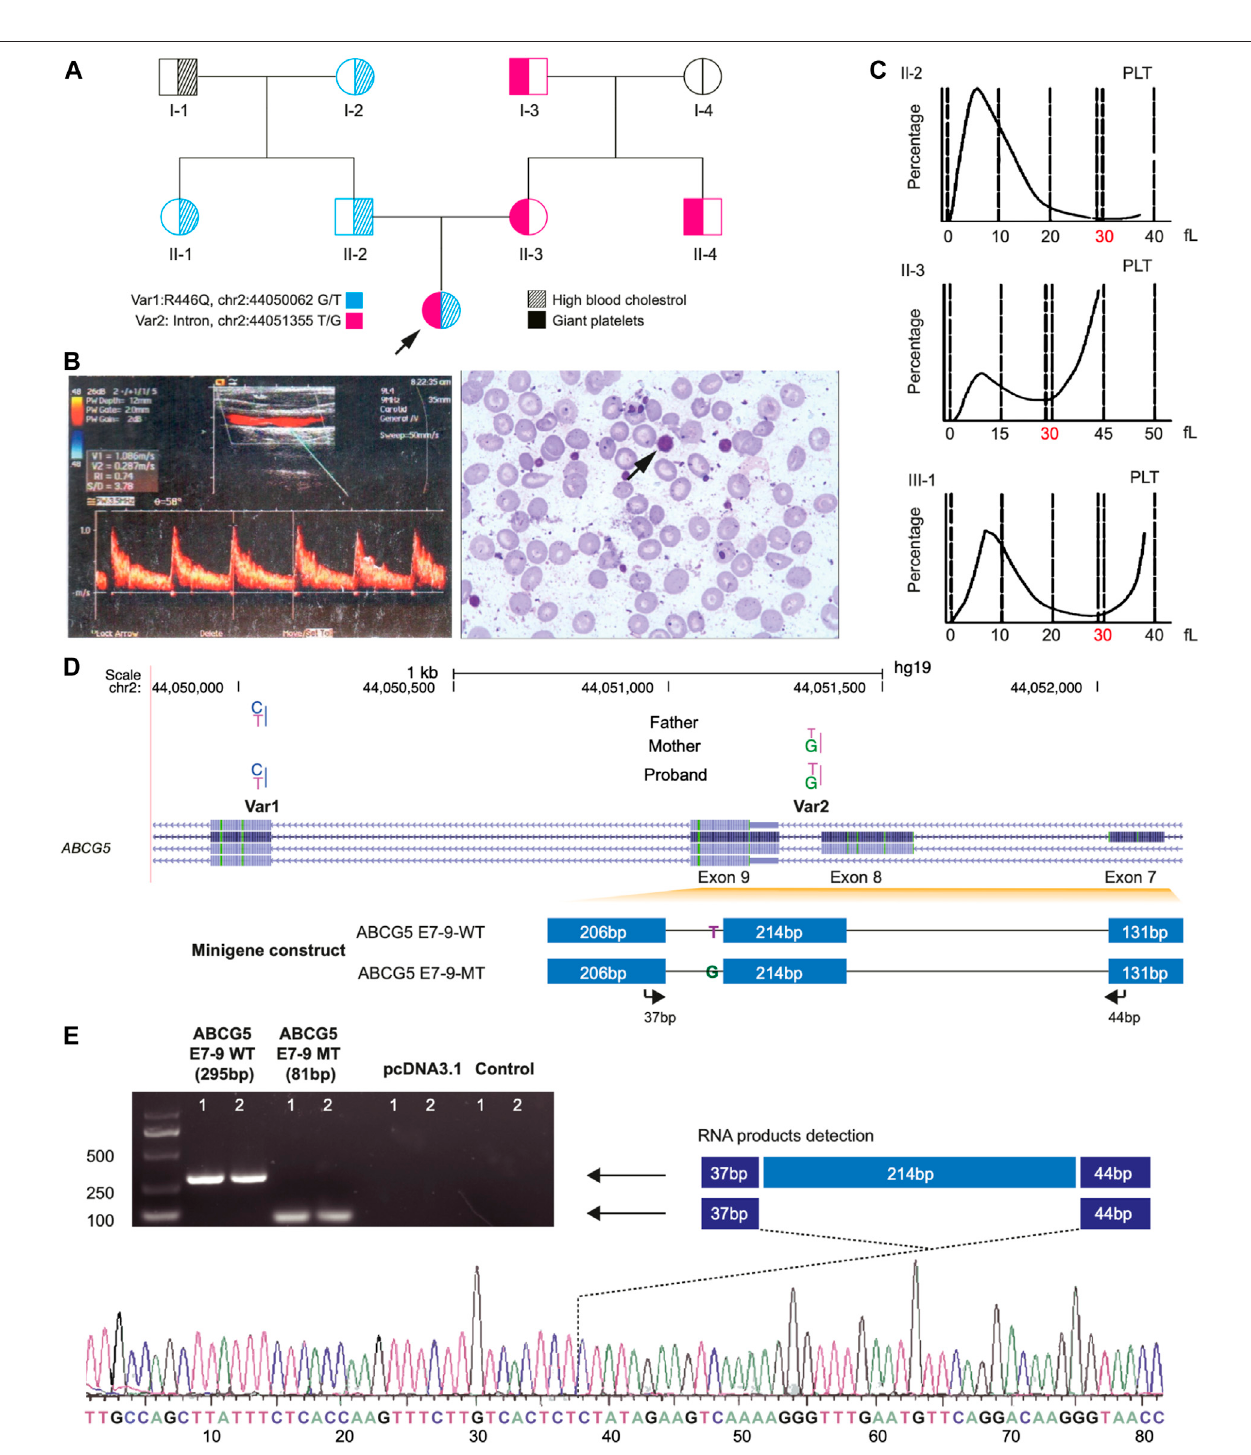
FIGURE1| ClinicalPhenotypesandIdenti fi cationofTwoNovelMutationsof ABCG5 Geneoftheprobandinapedigreefamily.Panel (A) showsthelargeplateletin the blood smear (left) and the atherosclerotic plaque by B-mode ultrasound measurement from the proband. Panel (B) , a pedigree chart shows the phenotype distribution in all family members and the transmission of two novel variants (Var 1 and Var 2) of ABCG5 in the family. Panel (C) shows the size distribution of platelets (PLT)intheprobandandherparents.Thedashlinesrepresenttheplatelets ’ volume,andthedoubledashlinesindicate30 fl ,inwhich40 fl istheuplimitationforthe normal distribution ofPLT. Panel (D) shows the ABCG5 genemodelfrom theNCBIdatabase and the inserted fragments intheconstructsfor wildtype and Var2mutant in the splicing pattern assay. The arrows indicate the primer pairs used for the detection of the mRNA products which were transcribed from the constructs. Panel (E) shows the PCR ampli fi cation results of two products generated from wild-type and Var2 mutant constructs, respectively. The product from the wild-type construct is 295 bp, and the product for the mutant is 81 bp due to deleting exon 8 of the ABCG5 gene. The truncated transcripts were further veri fi ed by Sanger sequencing.